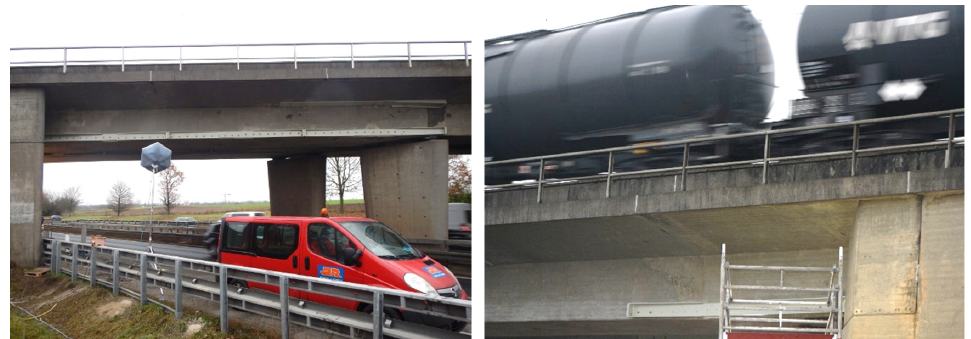
Figure 5. Strengthening of the railway bridge over the highway A70 under ongoing use on and under the